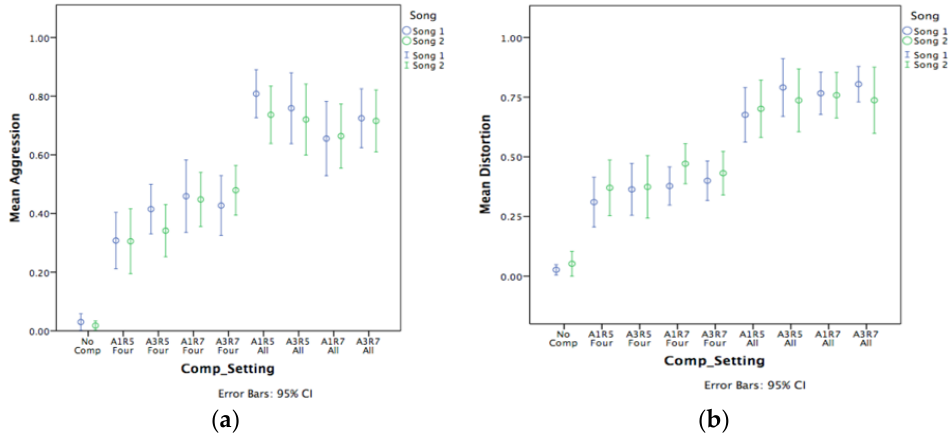
Figure 4. ( a ) Results for the descriptor aggressive from listening experiment 1; ( b ) results for the distortion from listening experiment 1. Note, no significance was found between time constant settings, but significance was found between ratio settings.